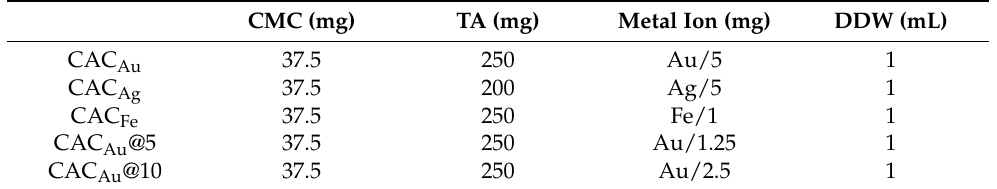
Table 2. Precursor compositions of different CAC